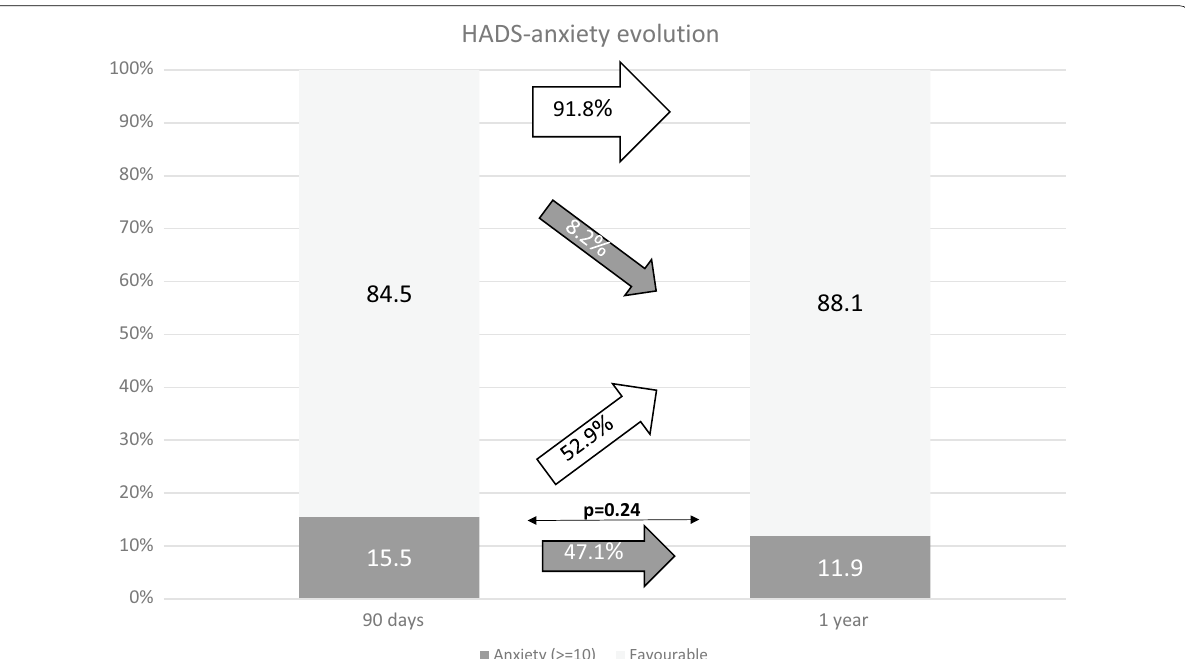
Fig. 5 Rate of favorable results in the anxiety items of HADS scale and anxiety diagnosed by HADS at different time‑points along follow‑up: 90 days and one year after stroke. The white arrows represent the rate of patients with improvement in the measured PROM or persistence of favorable outcome at the following time‑point of evaluation. The gray arrows represent impairment toward an unfavorable result in the measured PROM or unfavorable outcome persistence. Thin arrows represent statistical comparison of the rate of favorable/unfavorable outcomes as compared with the